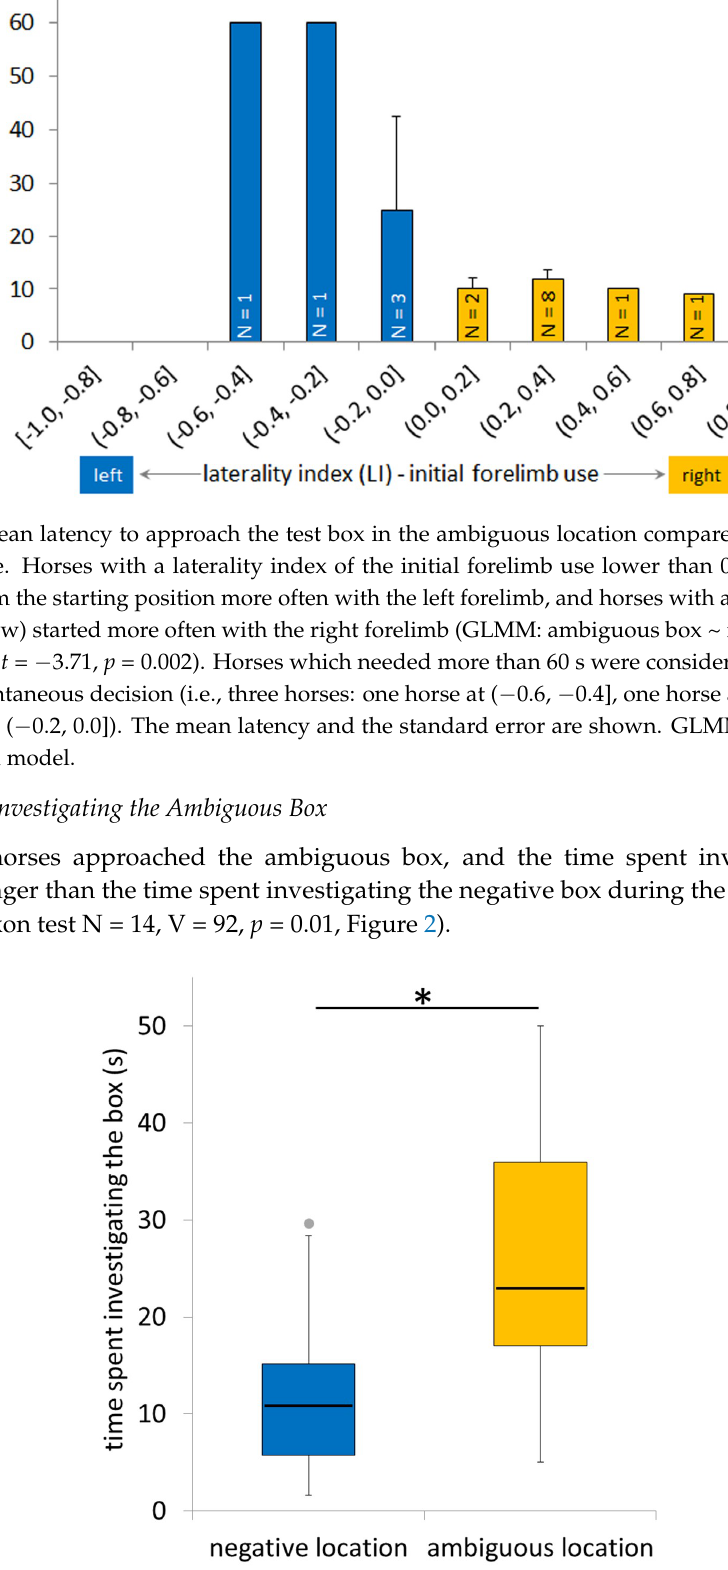
Figure 2. Time spent investigating the box at the ambiguous location (i.e., the novel location where the horses did not know whether it could be opened) compared with mean time spent investigating the box at the negative location (i.e., the location where the horses knew it was locked) during the last three training sessions ( N = 14). * p < 0.05.